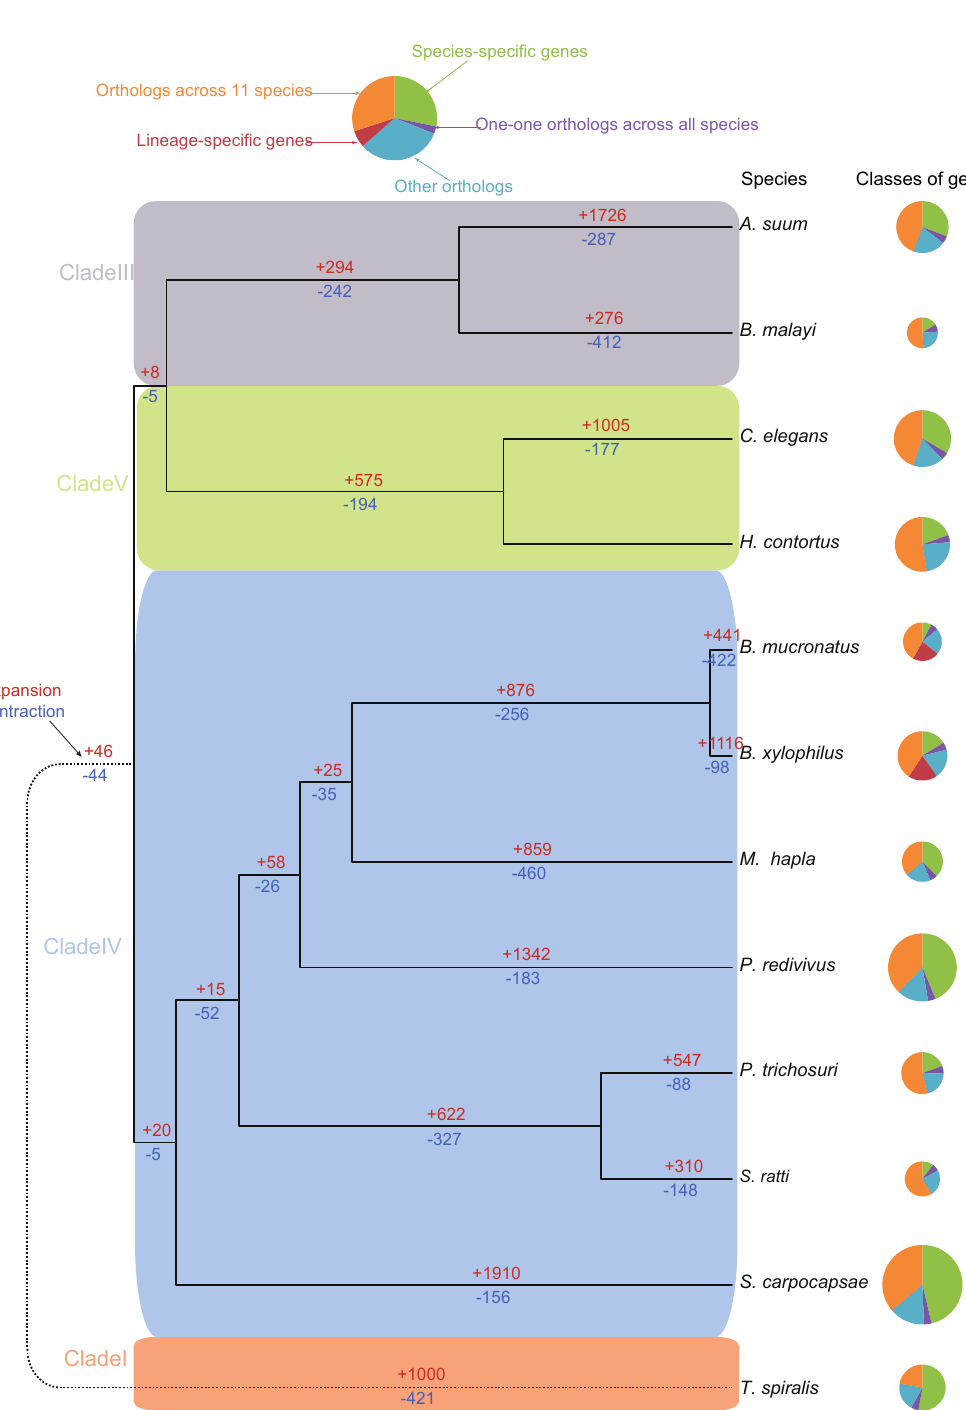
Figure 4. Phylogeny and gene families of B. mucronatus and related species . The phylogenetic relationship was inferred by RAxML, based on orthologous proteins of the 497 single-copy gene families. The circle size represents gene number, and the different colors indicate different gene types showed in the right top of the figure. The numbers above (red) and below (blue) indicate number of expansed and contracted gene families, respectively. The colors of the strips within the phylogenetic tree indicate different classes of the nematodes.